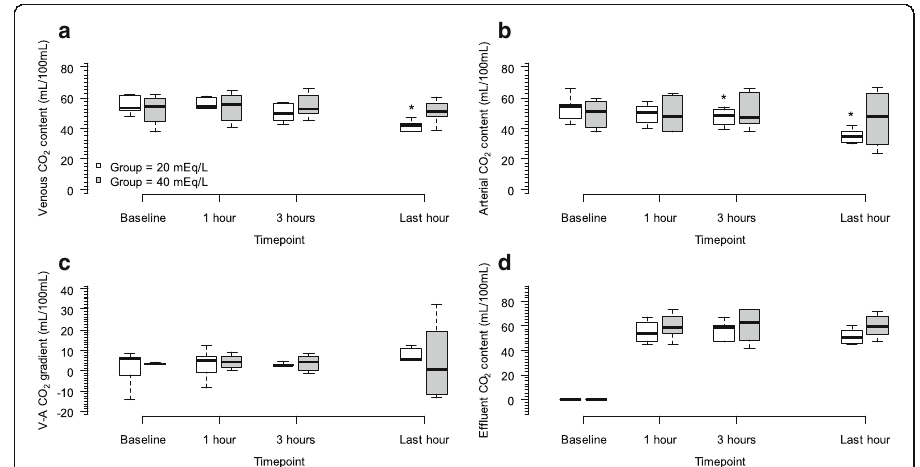
Fig. 4 Temporal changes of CO 2 content over RRT. Panel a shows the venous CO 2 content evolution over the time (mixed model: group vs. venous CO 2 content interaction, P = 0.230; timepoint vs. venous CO 2 content interaction, P < 0.001; timepoint vs. group interaction, P < 0.001). Panel b shows the arterial CO 2 content changes over time (mixed model: group vs. arterial CO 2 content interaction, P = 0.231; timepoint vs. arterial CO 2 content interaction, P < 0.001; timepoint vs. group interaction, P < 0.001). Panel c shows the venous-arterial CO 2 gradient changes over time (mixed model: group vs. venous-arterial CO 2 gradient interaction, P = 0.815; timepoint vs. venous-arterial CO 2 gradient interaction, P = 0.919; timepoint vs. group interaction, P = 0.972). Panel d shows the effluent CO 2 content changes over time (mixed model: group vs. effluent CO 2 content interaction, P =0.769; timepoint vs. effluent CO 2 content interaction, P =0.136; timepoint vs. group interaction, P =0.242), for the effluent CO 2 content, the baseline data were excluded. *Wilcoxon post hoc analysis, P < 0.05 vs.